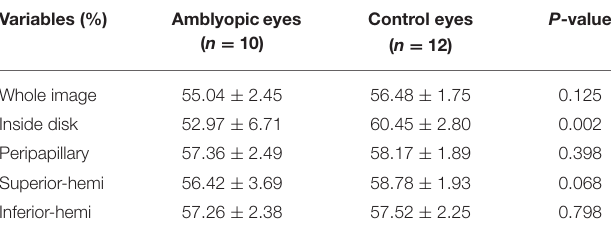
TABLE 5 | Peripapillary capillary all vessel density in amblyopic and control subjects.